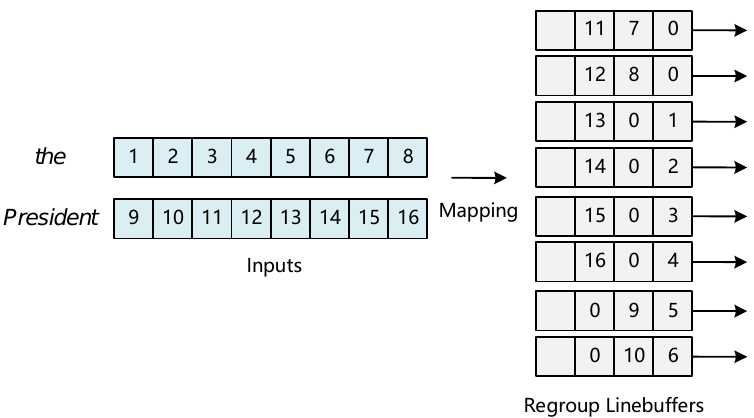
Figure 7. Example for input mapping strategy with p = 4 and d =